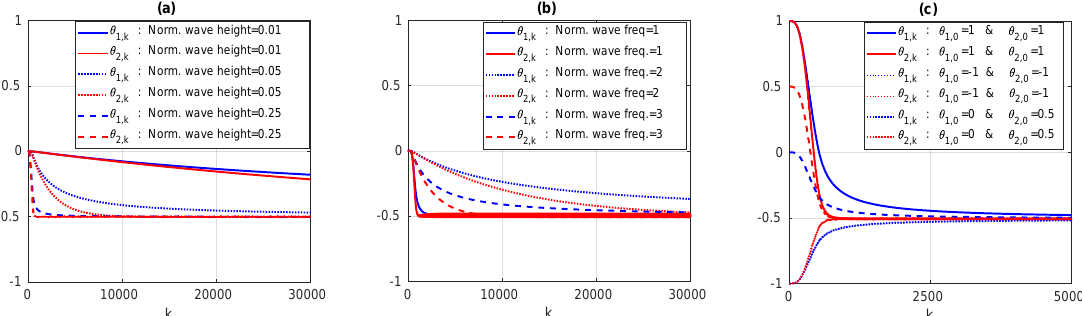
Figure 3. The online adaptation of θ i , k using the recursive least squares algorithm. For monochromatic waves with: ( a ) a normalised wave frequency of 1.6 and varying wave height; ( b ) a normalised wave amplitude of 0.01 and varying wave frequency; and ( c ) a normalised wave frequency of 3, a normalised wave height of 0.1 and varying initial